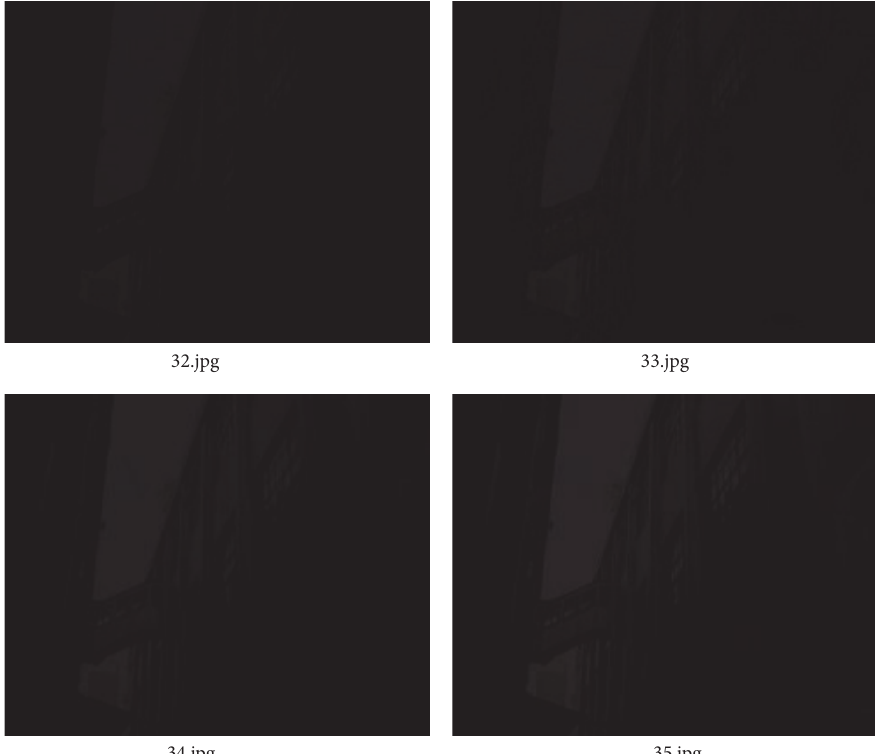
Figure 1: Four frames with low gray value extracted from a tested